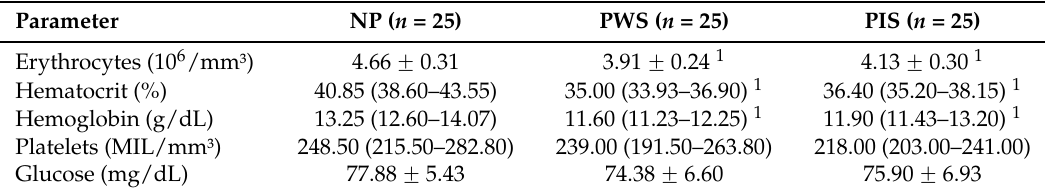
Table 2. Hematological and biochemical parameters of pregnant and non-pregnant women.